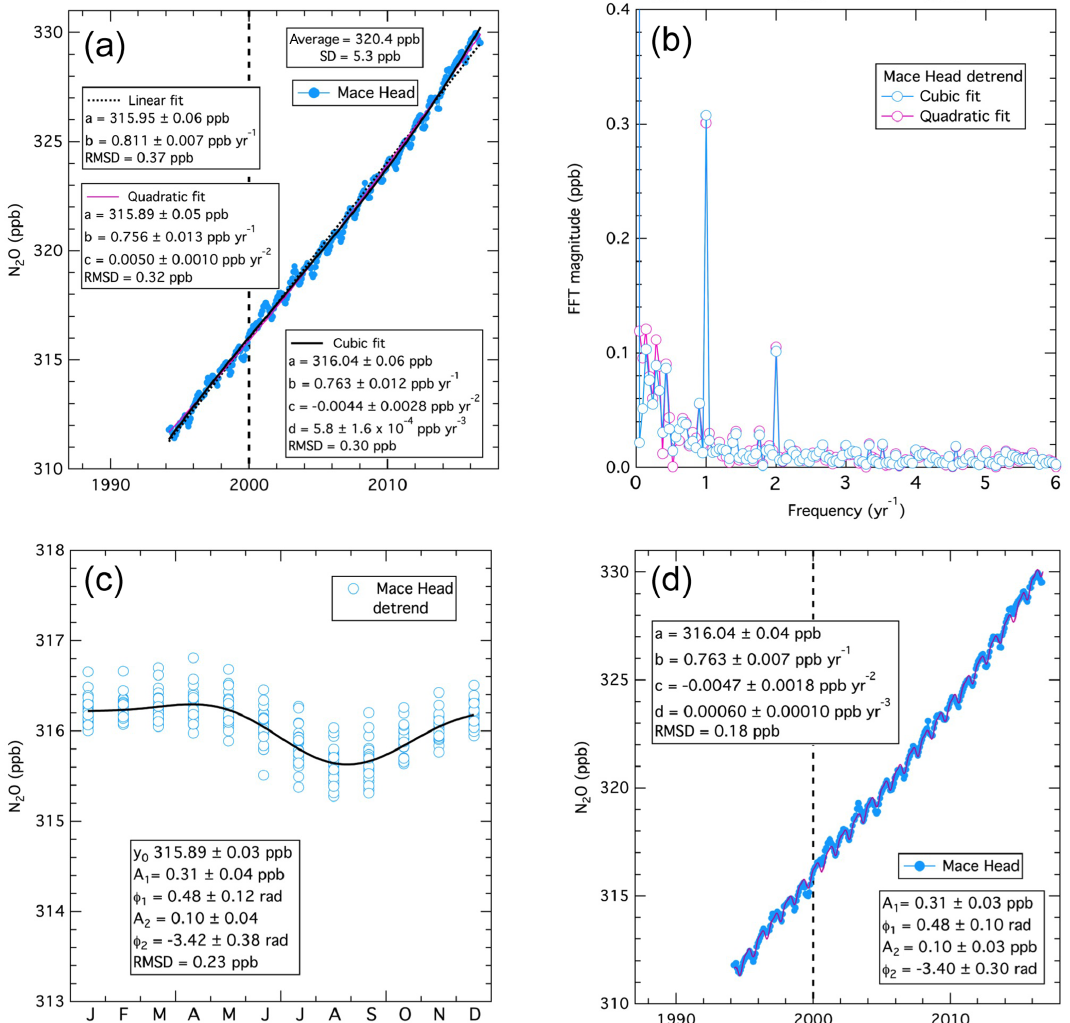
Figure 5. Analysis results for a time series of monthly mean baseline nitrous oxide measured at Mace Head, Ireland. (a) The three curves are fits of the monthly means to Eq. (1) with two terms (i.e., linear), three terms (i.e., quadratic) and four terms (i.e., cubic), with the derived parameters annotated. (b) Results of the Fourier transform of the monthly mean concentrations detrended using the cubic (blue points) and quadratic fits (violet points). (c) Results of the fit of Eq. (3) to the detrended monthly mean concentrations. The black curve is the nonlinear regression of Eq. (3) to the plotted points. (d) Results of the cubic fit (violet curve) of Eq. (4) to the detrended monthly mean concentrations. Table 2 gives the parameter values and the confidence limits corrected for autocorrelation in the data